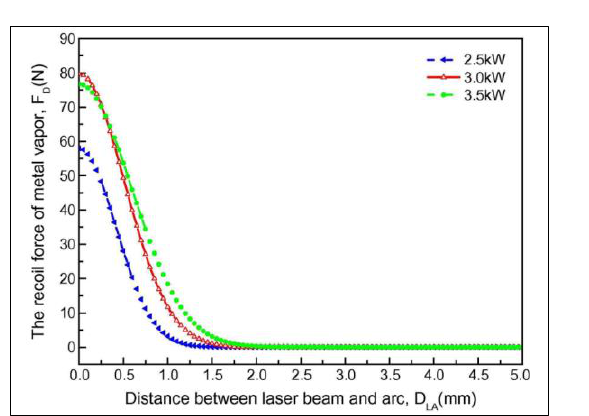
Figure 23. The connection between D LA and the reaction force of metal vapor [77]. Reprinted with permission from [77] 2013 Elsevier. In order to obtain smooth and steady droplet transfer and reduce the loss of laser heat input, many researchers changed the conventional process parameters (including laser power and laser-to-arc distance) to solve the problem. Due to the narrowing of the window of process parameters, it is difficult to achieve excellent hybrid welding between